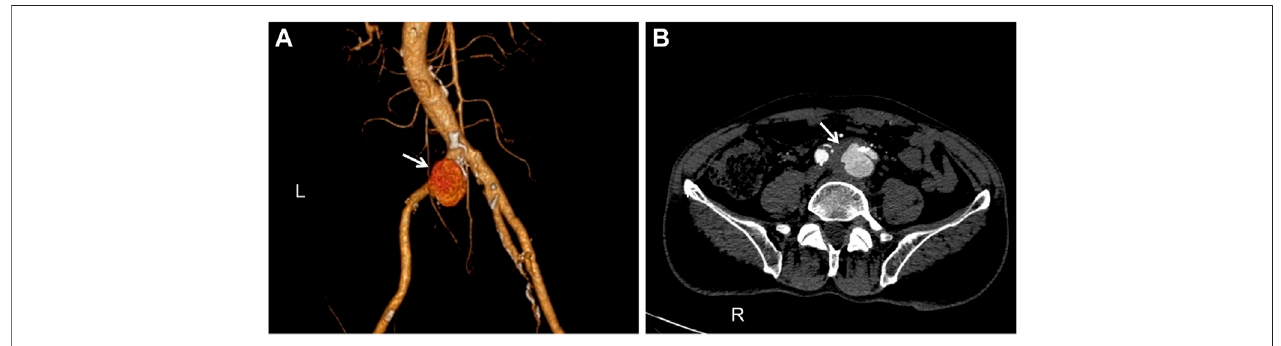
FIGURE 1 | Computed tomography angiography (CTA): (A) . The pseudoaneurysm has a maximum diameter of 33 mm and is placed near the commencement of the left common iliac artery (white arrow). (B) . A breach is visible in the arterial wall, and there is an over fl ow of contrast agents (white